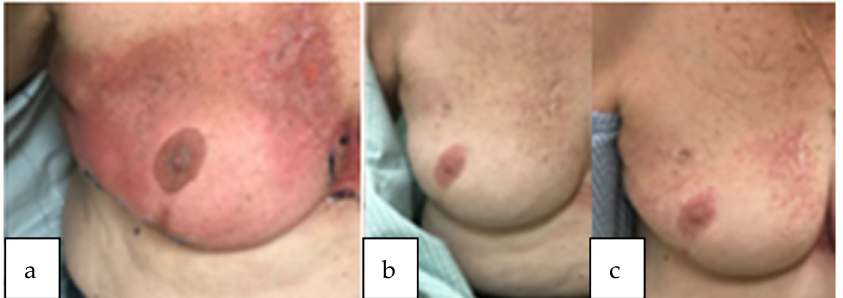
Figure 1. Patient with acute dermatitis grade 3 during radiation treatment ( a ) subsequently devel- oped worsening telangiectasia at 1 year and 2 year follow-up ( b , c ). Course 1: mammosite balloon brachytherapy to 34 Gy and course 2: WBRT to 46.8 Gy in 26 daily fractions with 14 Gy lumpectomy cavity boost.